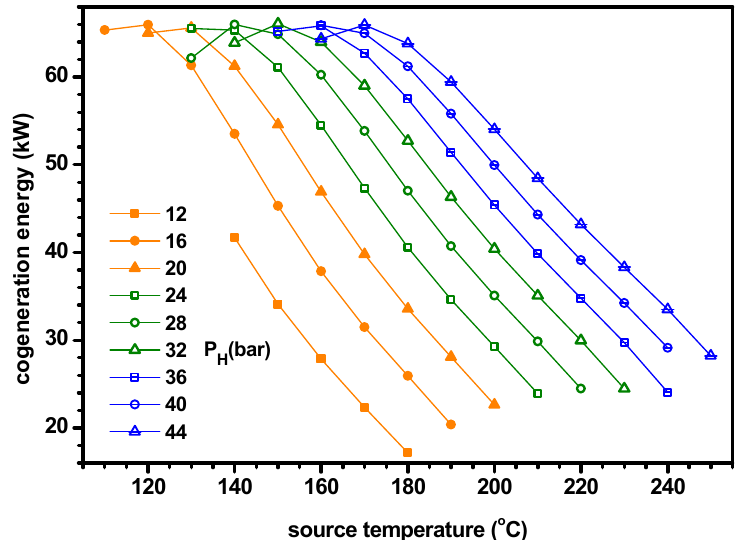
Energies 2019 , 12 , x FOR PEER Figure 18. Effect of source temperature on the cogeneration energy. Figure 18. E ff ect of source temperature on the cogeneration energy.